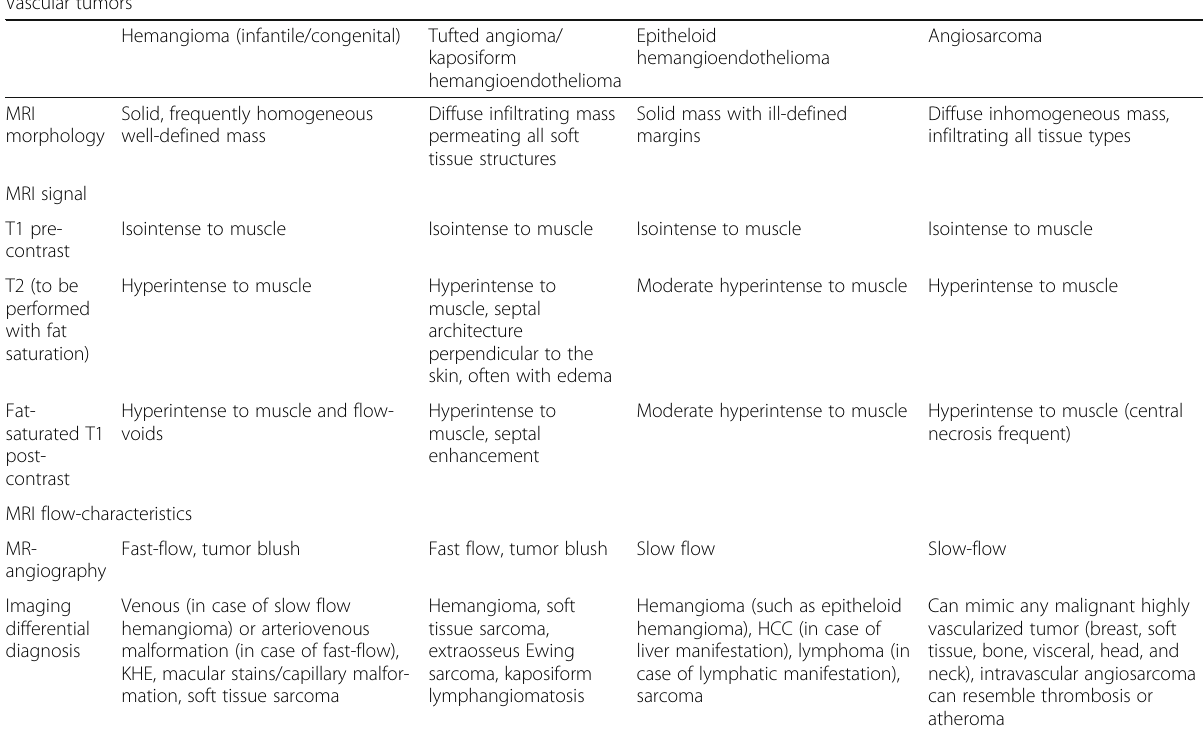
Table 3 MR imaging of vascular tumors of different malignancy Vascular tumors Hemangioma (infantile/congenital)